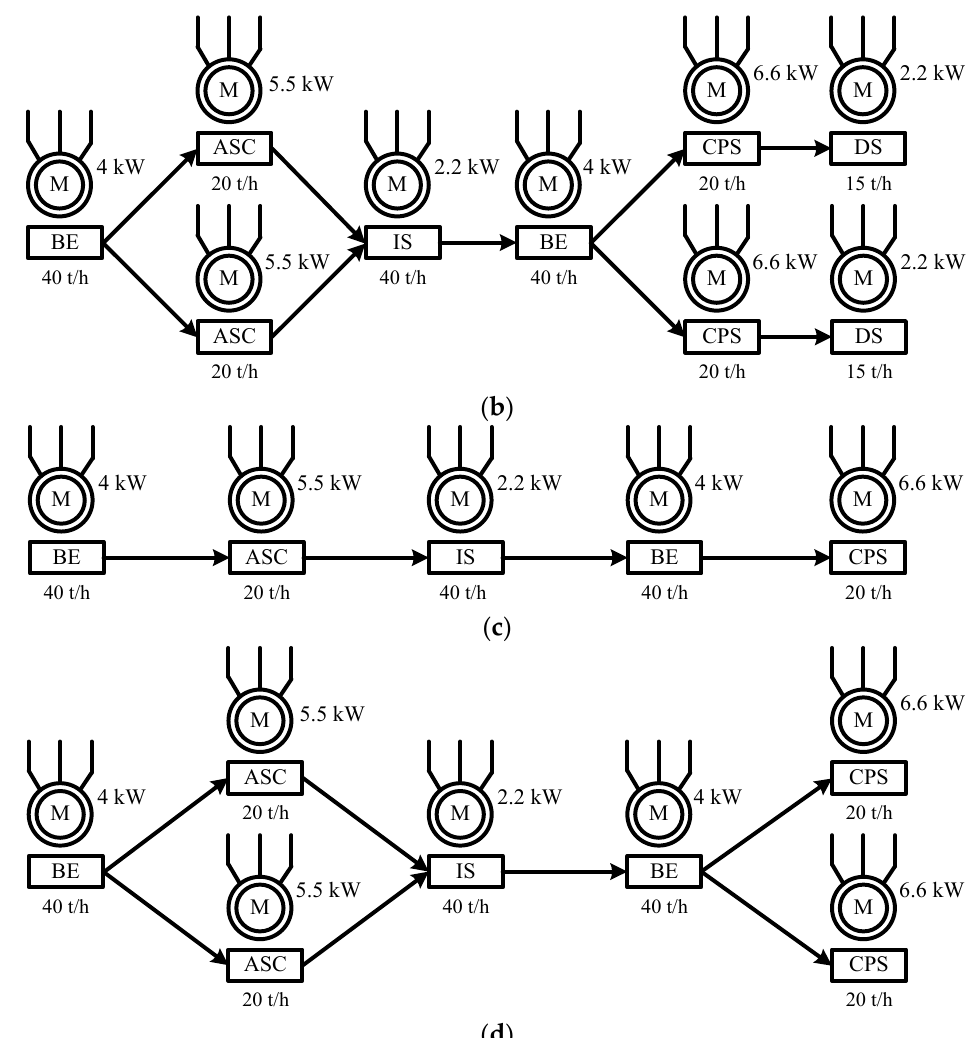
Figure 1. Technological schemes of ZAV-40 grain cleaning unit: M—induction motor, BE—bucket elevator, ASC—air screen cleaner, IS—intermediate screw, CPS—centrifugal pneumatic separator, DS—disc separator.